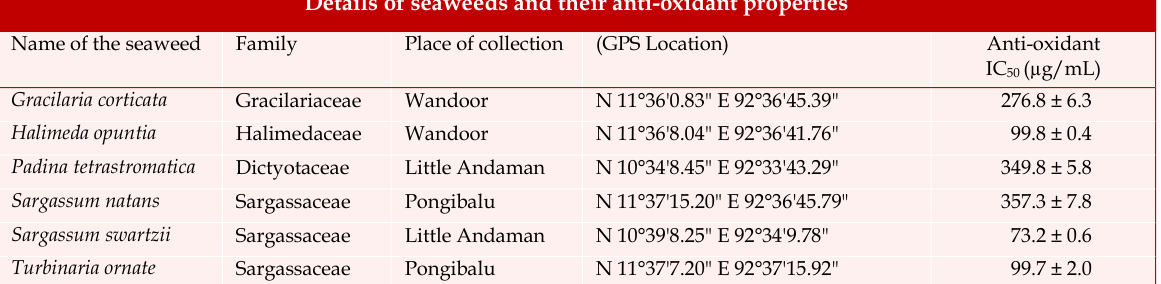
Details of seaweeds and their anti-oxidant properties Name of the seaweed